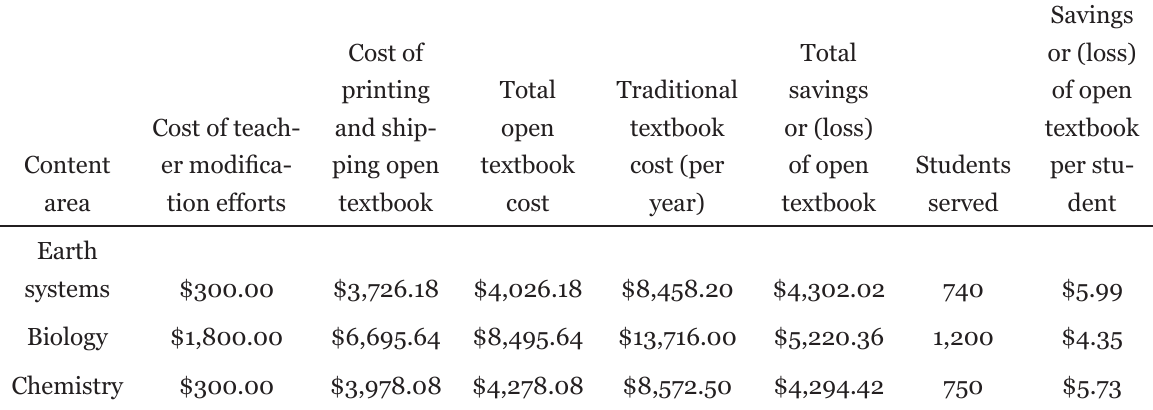
Summary of Cost Data for Open and Traditional Textbooks